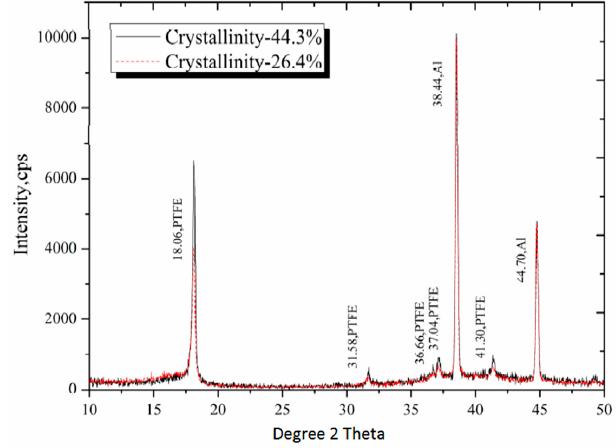
Figure 3. X-ray diffraction patterns of low and high crystalline Al-PTFE.